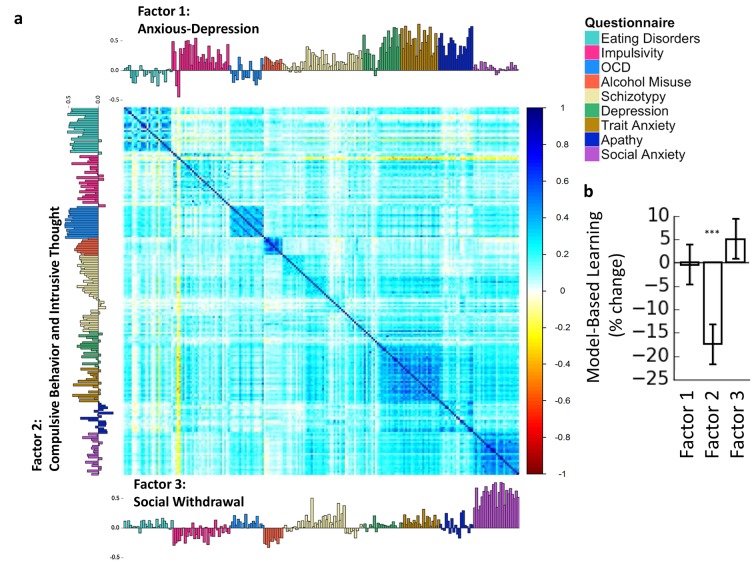
Trans-diagnostic factors.(a) Factor analysis on the correlation matrix of 209 questionnaire items suggested that 3-factor solution best explained these data. Factors were ‘Anxious-Depression’, ‘Compulsive Behavior and Intrusive Thought’ and ‘Social Withdrawal’. Item loadings for each factor are presented on the top, left and bottom sides of the correlation matrix, color-codes indicate the questionnaire from which each item was drawn. (b) These factors were entered into mixed-effects models, revealing that only the Factor 2 ‘Compulsive Behavior and Intrusive Thought’ was associated with goal-directed deficits, the effect size (17% reduction in model-based learning for every 1 SD increase in ‘Compulsive Behavior and Intrusive Thought’) was larger than for any individual questionnaire, and pairwise contrasts revealed that these deficits were specific to this factor, compared to Factor 1 ‘Anxious-Depression’ and Factor 3 ‘Social Withdrawal’. The y-axes indicate the% change in model-based learning for each change of 1 standard deviation (SD) of clinical symptomatology. Error bars denote standard error.